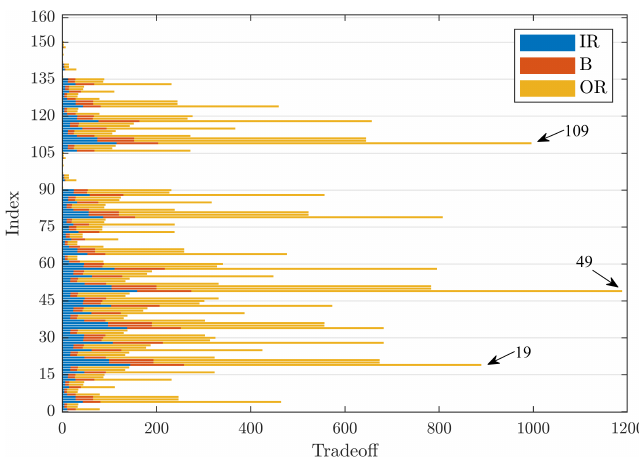
Figure 5. Comparison of TO values for defects of size 0.007